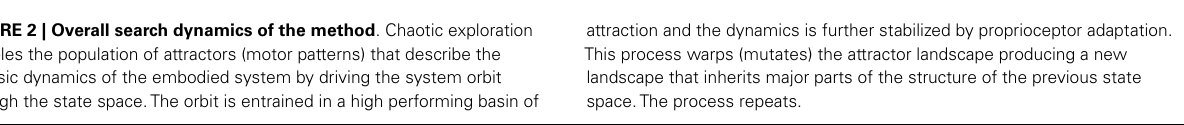
attraction and the dynamics is further stabilized by proprioceptor adaptation. This process warps (mutates) the attractor landscape producing a new landscape that inherits major parts of the structure of the previous state space.The process